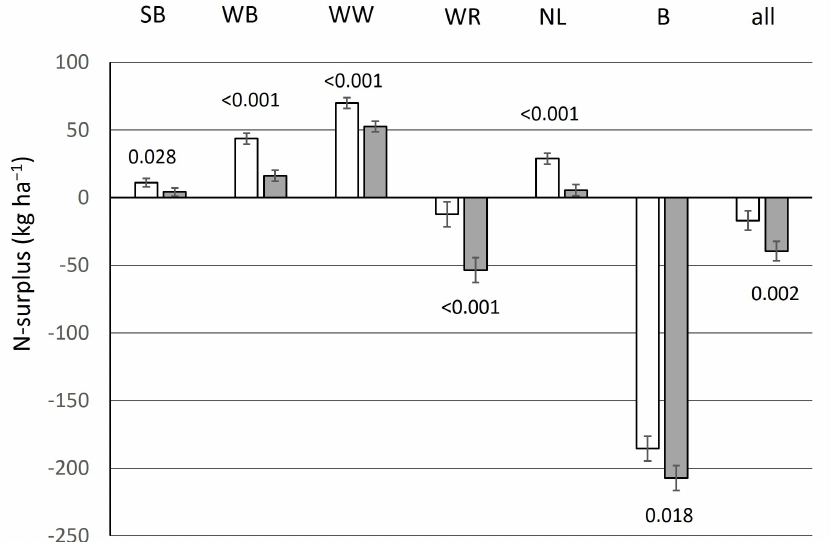
Figure 5. Mean N-surplus over five years, negative values indicating crops held more nitrogen than was applied, in (unshaded) standard and (shaded) integrated treatments of spring barley (SB), winter barley (WB), winter wheat (WW), winter oilseed rape (WR), the four non-legumes combined (NL), the grain legume spring bean (B) and all five crops combined (all), plus and minus SE, significance of difference indicated by p